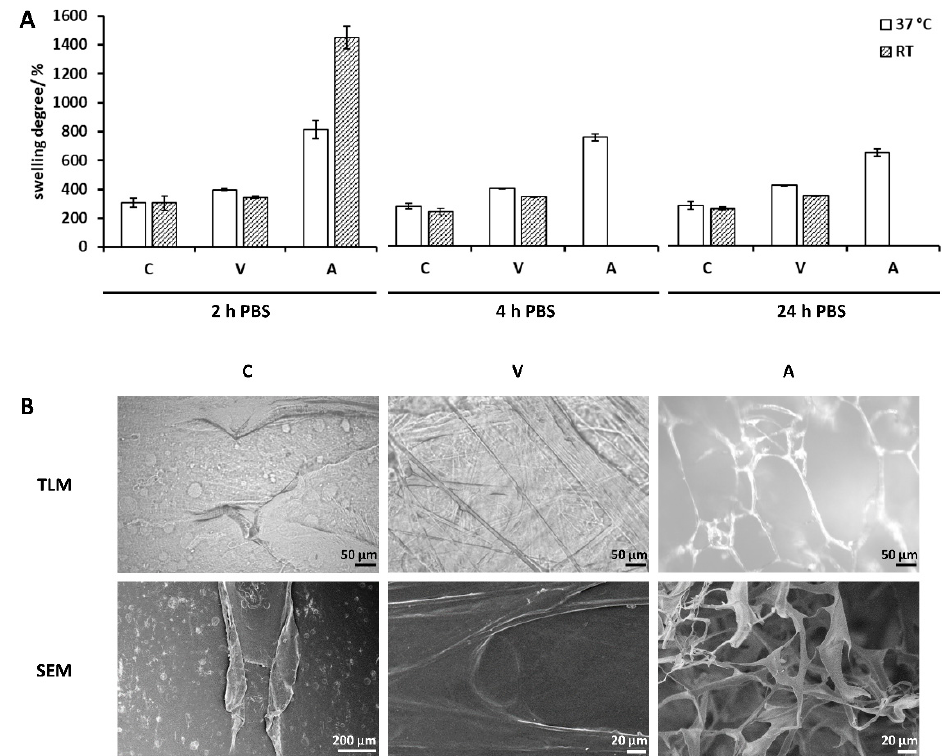
Figure 3. Swelling behavior and microstructure of collagen sheets. ( A ) Swelling degree of collagen sheets “as received” at 37 °C and RT after 2 h, 4 h and 24 h in relation to their dry weight (100%). ( B ) transmitted light microscopy (TLM) and SEM images of collagen sheets. Samples analyzed via TLM were conditioned in phosphate-buffered saline (PBS). TLM magnification: 200×. SEM magnification: V and A: 1000×, C: 200×. C: Collagen Solutions, V: Viscofan and A: Atelocollagen.